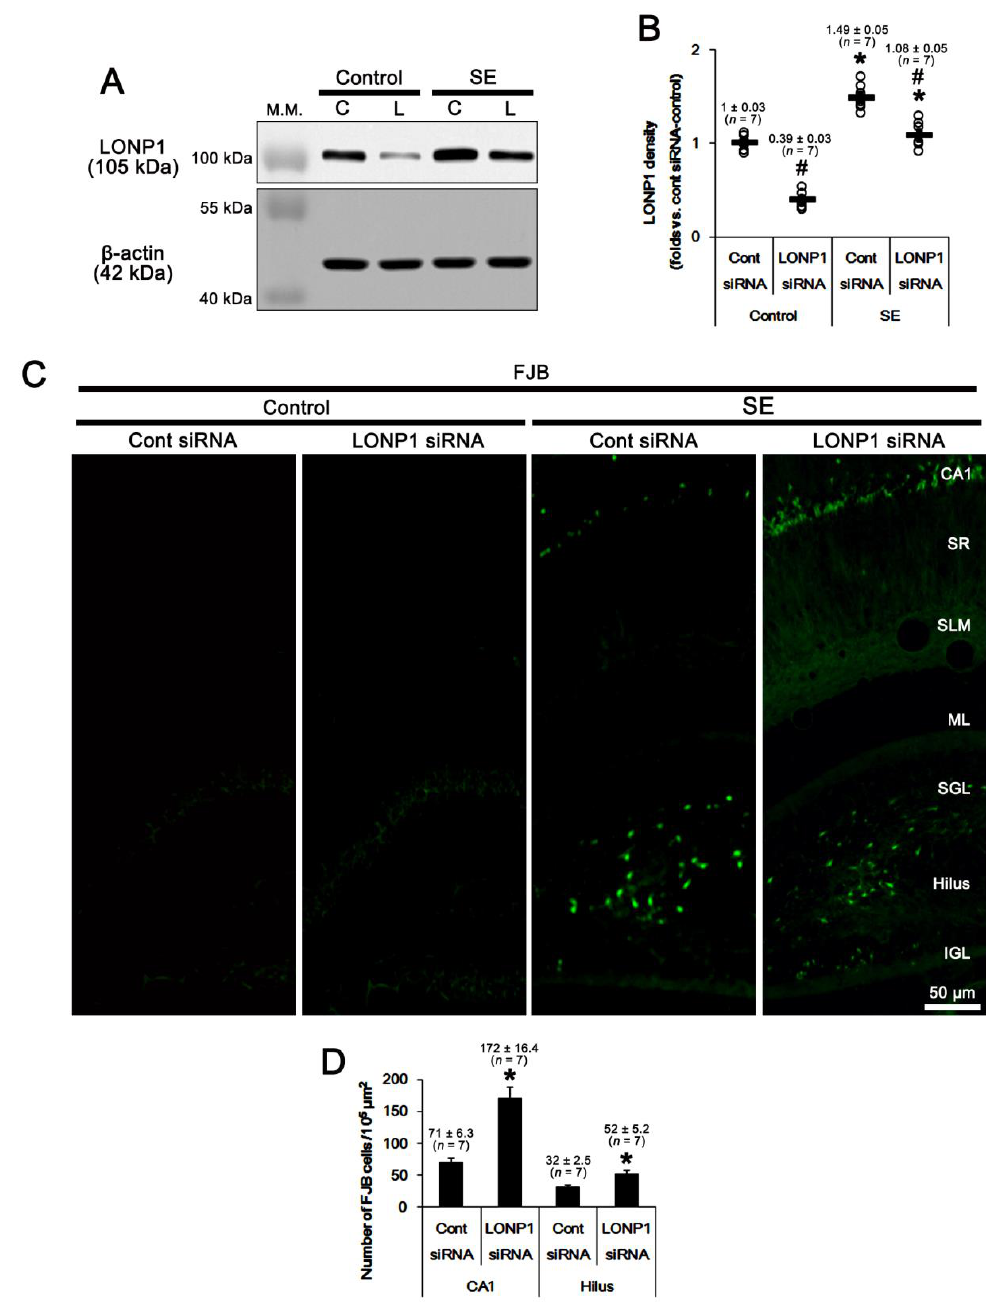
Figure 4. Effects of control siRNA and LONP1 siRNA on LONP1 expression and neuronal death in response to pilocarpine. SE increases LONP1 expression level. As compared to control siRNA (Cont siRNA, C), LONP1 siRNA (L) decreases LONP1 protein level under physiological and post-SE condition. ( A ) Representative Western blots of LONP1 protein level in the whole hippocampus (M.W. marker, molecular weight marker). ( B ) Quantification of LONP1 protein level based on Western blot data. Open circles indicate each individual value. Horizontal bars indicate mean value (mean ± S.E.M.; * ,# p < 0.05 vs. control animals and control siRNA, respectively; one-way ANOVA). ( C ) Representative Fluoro-Jade B (FJB) staining images. LONP1 siRNA exacerbates SE-induced degenerations of CA1 neurons and hilus (including PV) interneurons, presumably including PV cells. Abbreviations: CA1, CA1 pyramidal cell layer; SR, stratum radiatum; SLM, stratum lacunosum-moleculare; ML, the molecular layer of the dentate gyrus; SGL, superior dentate granule cell layer; IGL, inferior dentate granule cell layer. ( D ) Quantification of the number of FJB-positive CA1- and hilus interneurons, presumably including PV cells, following SE (mean ± S.E.M.; * p < 0.05 vs. control siRNA; Student’s t -test). Abbreviations: CA1, CA1 neurons; Hilus, hilus interneurons, presumably including PV cells.